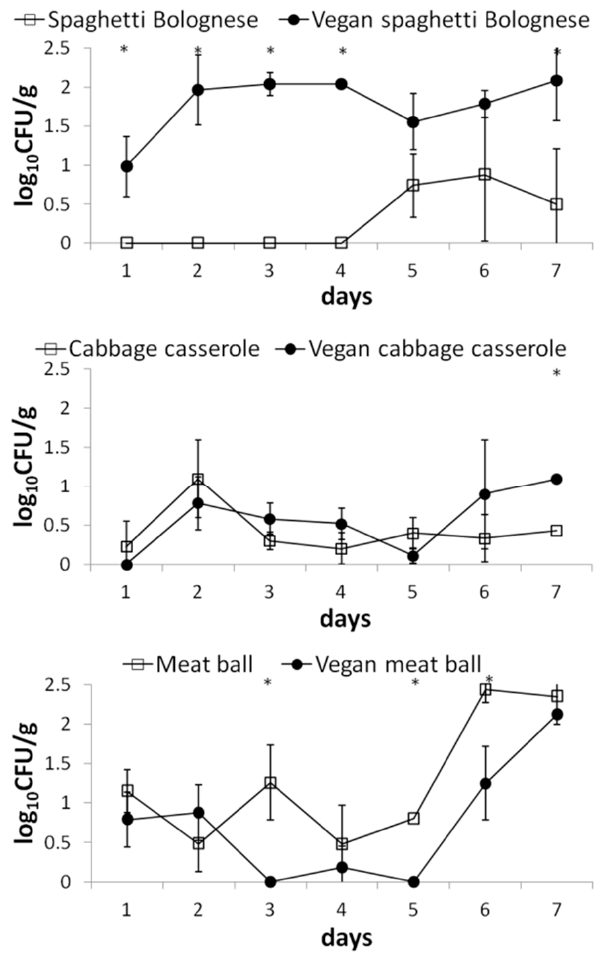
Figure 2. Changes in aerobic colony counts in refrigerated food. Mean values ± standard deviations are shown. Asterisks indicate significant differences between meat-containing and meatless samples at p < 0.05.